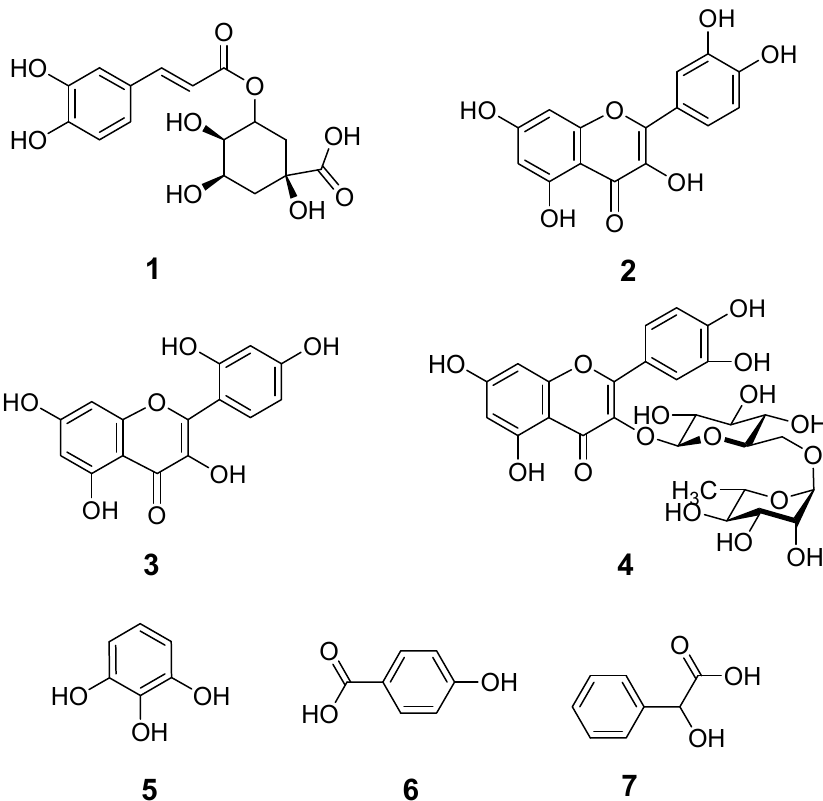
Figure 4. Chemical structures of the detected compounds.